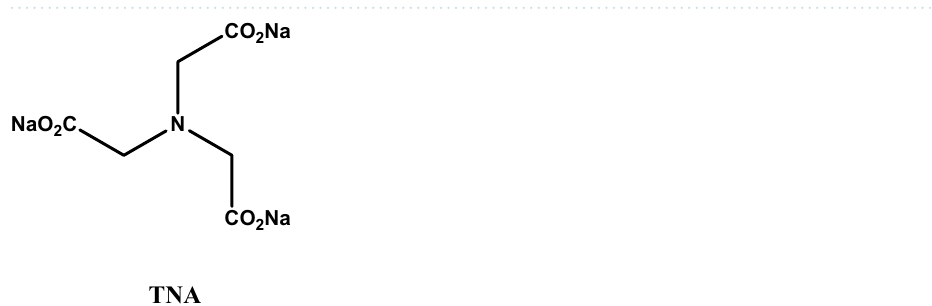
Table 1. Properties of the reactive dyes and its chemical structures.